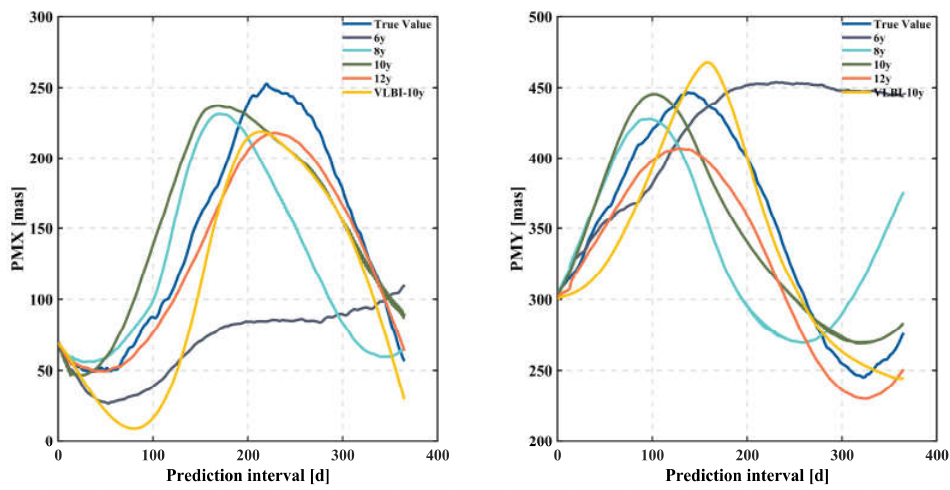
Scheme 6: Prediction of the polar motion series based on the ERP series estimated from 2011 to 2020 VLBI observations, with the CNN–LSTM method used for predic- tion. Figure 6 shows the comparison of polar motion prediction in different schemes. The experiments we performed showed that the 12-year base time series fits the true value better and the fit becomes closer to the true value with increased base time series length; unexpectedly, the 6-year base time series was a poor match to the true value. Notably, in the current study we found that the prediction of polar motion based on the ERP series estimated from 2011 to 2020 VLBI observations has a better fit. The accuracy statistics of the prediction results are shown in Table 5. Scheme 2 had the lowest accuracy, which may be due to the poor training model caused by the short time series. It is notable that the hybrid CNN–LSTM model with 12-year base time series had the highest polar motion prediction accuracy; compared with the LS + AR model, especially in medium-